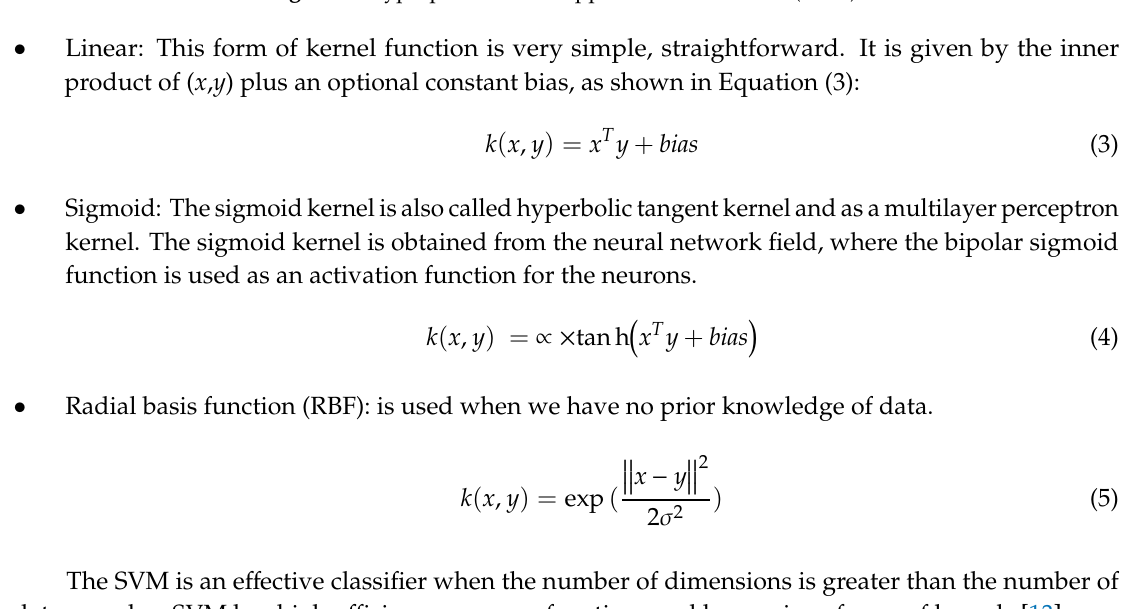
Figure 1. Hyperplane of the support vector machine (SVM).